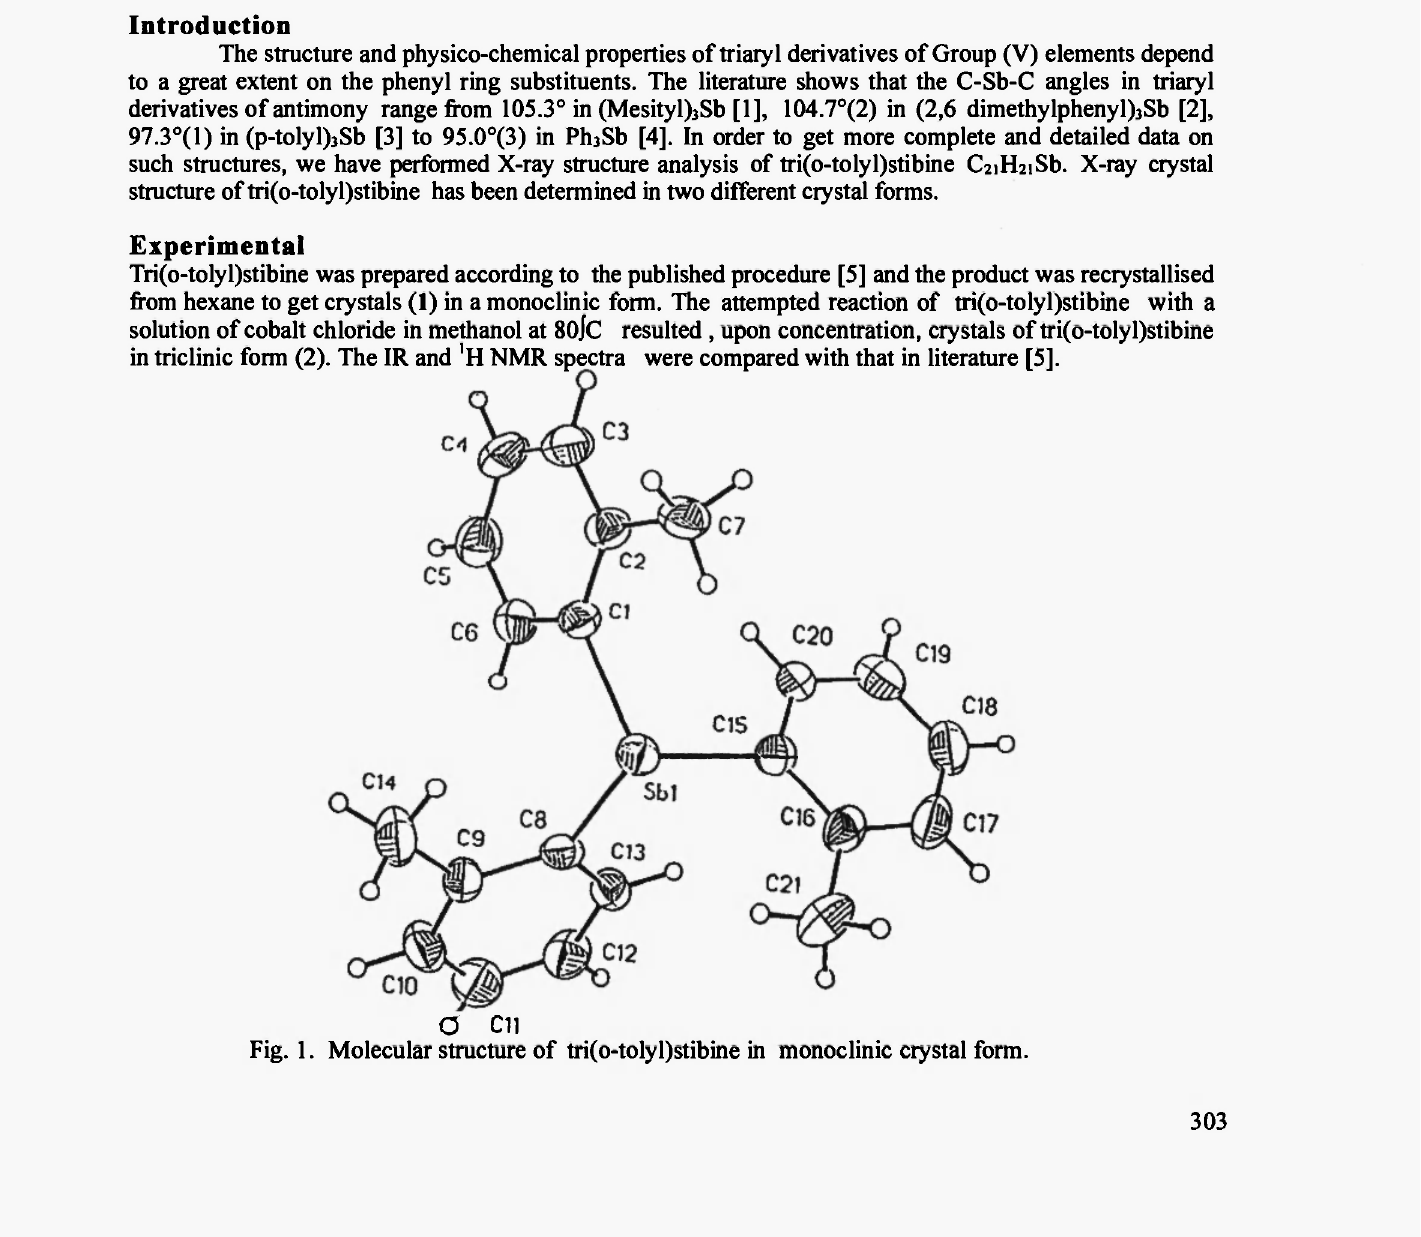
C11 Fig. 1. Molecular structure of tri(o-tolyl)stibine in monoclinic crystal